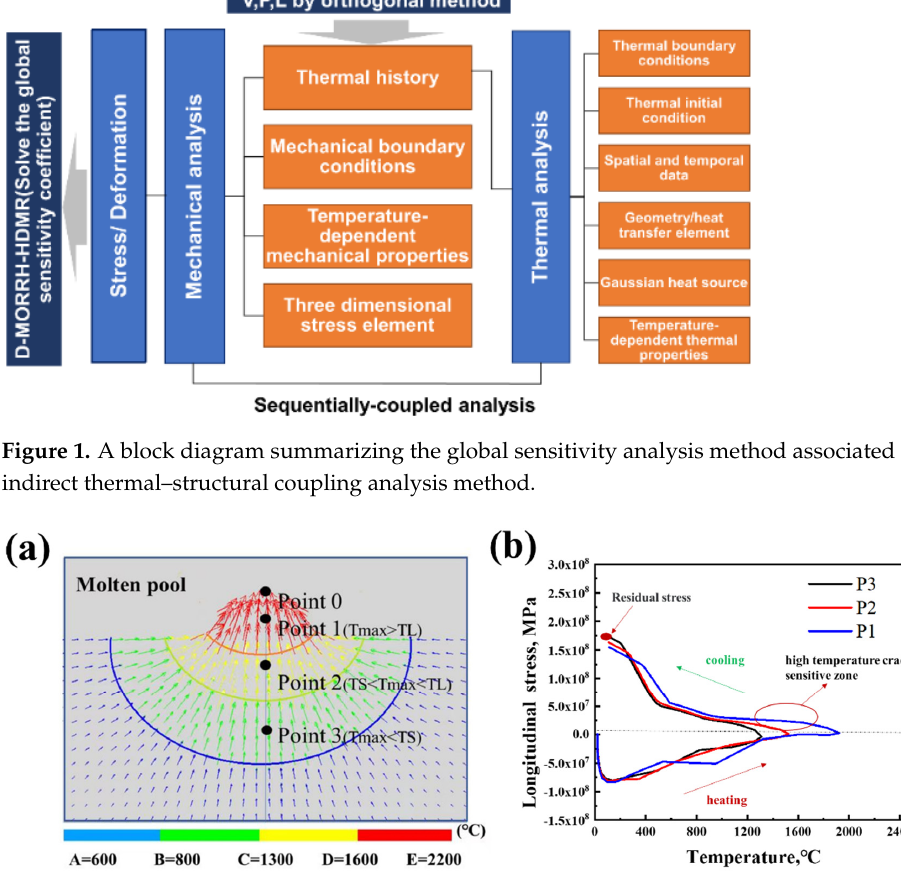
Figure 2. ( a ) The shape of molten pools in the DED additive process; ( b ) temperature–stress evolution curves at different locations.